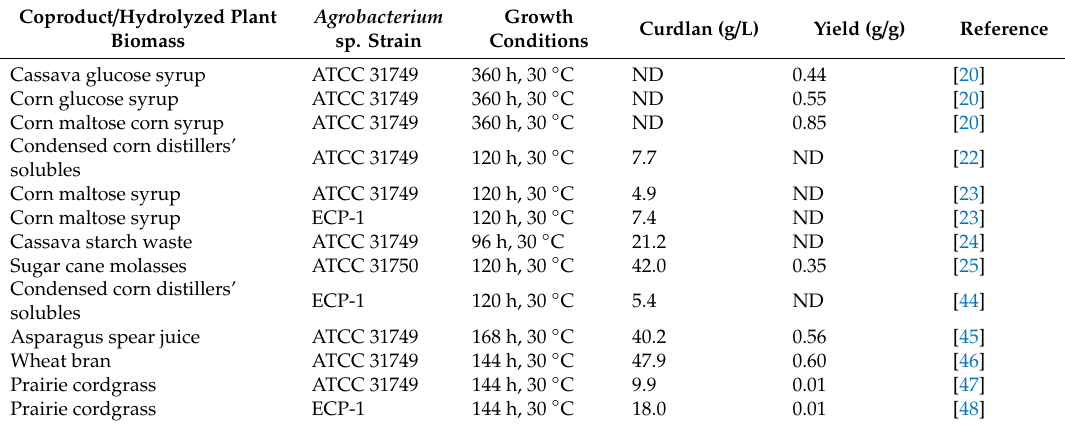
Table 1. Curdlan production and yield by strains grown on processing coproduct or hydrolyzed lignocellulosic